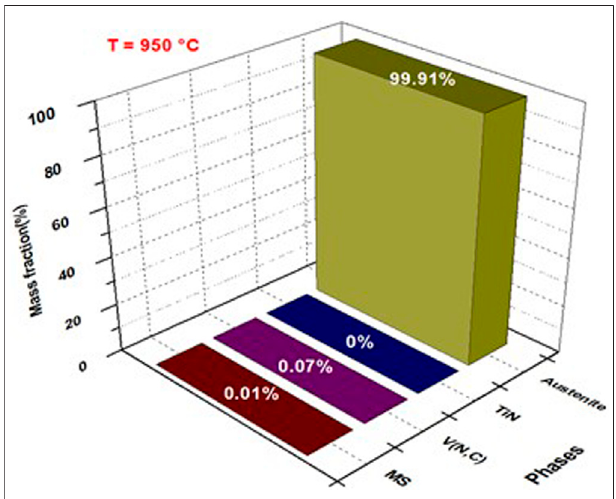
FIGURE 15 | Thermo-Calc result of sample at 950 ° C for single-point equilibrium.